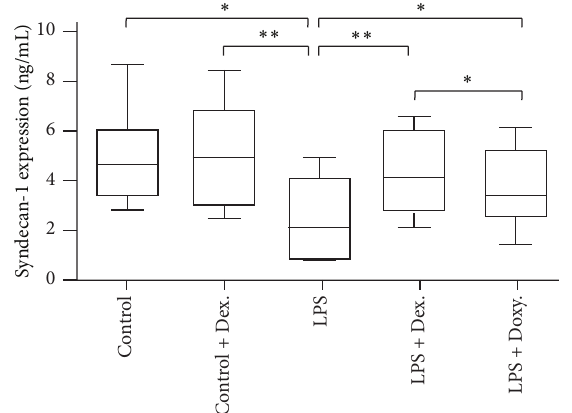
Figure 5: Quantification of syndecan-1 in aortic homogenates by ELISA (mean ± SD, 𝑛 = 8 ). ∗ 𝑝 < 0.05 ; ∗∗ 𝑝 < 0.001